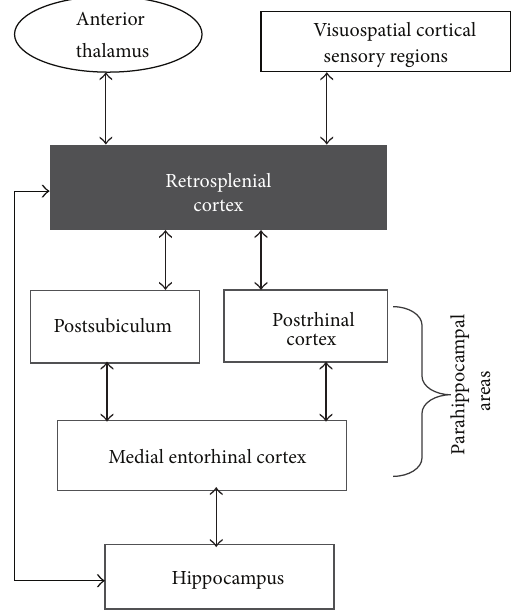
Figure2:MajorcorticalandthalamicafferentsandefferentsofRSC. Only the densest interconnections are illustrated for